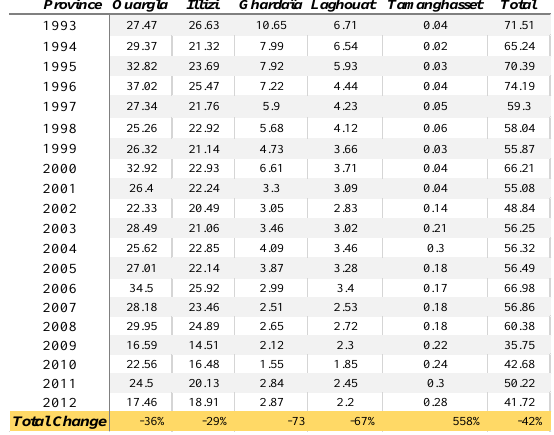
Table 4. Global of lights observed by DMSP data in gas flaring